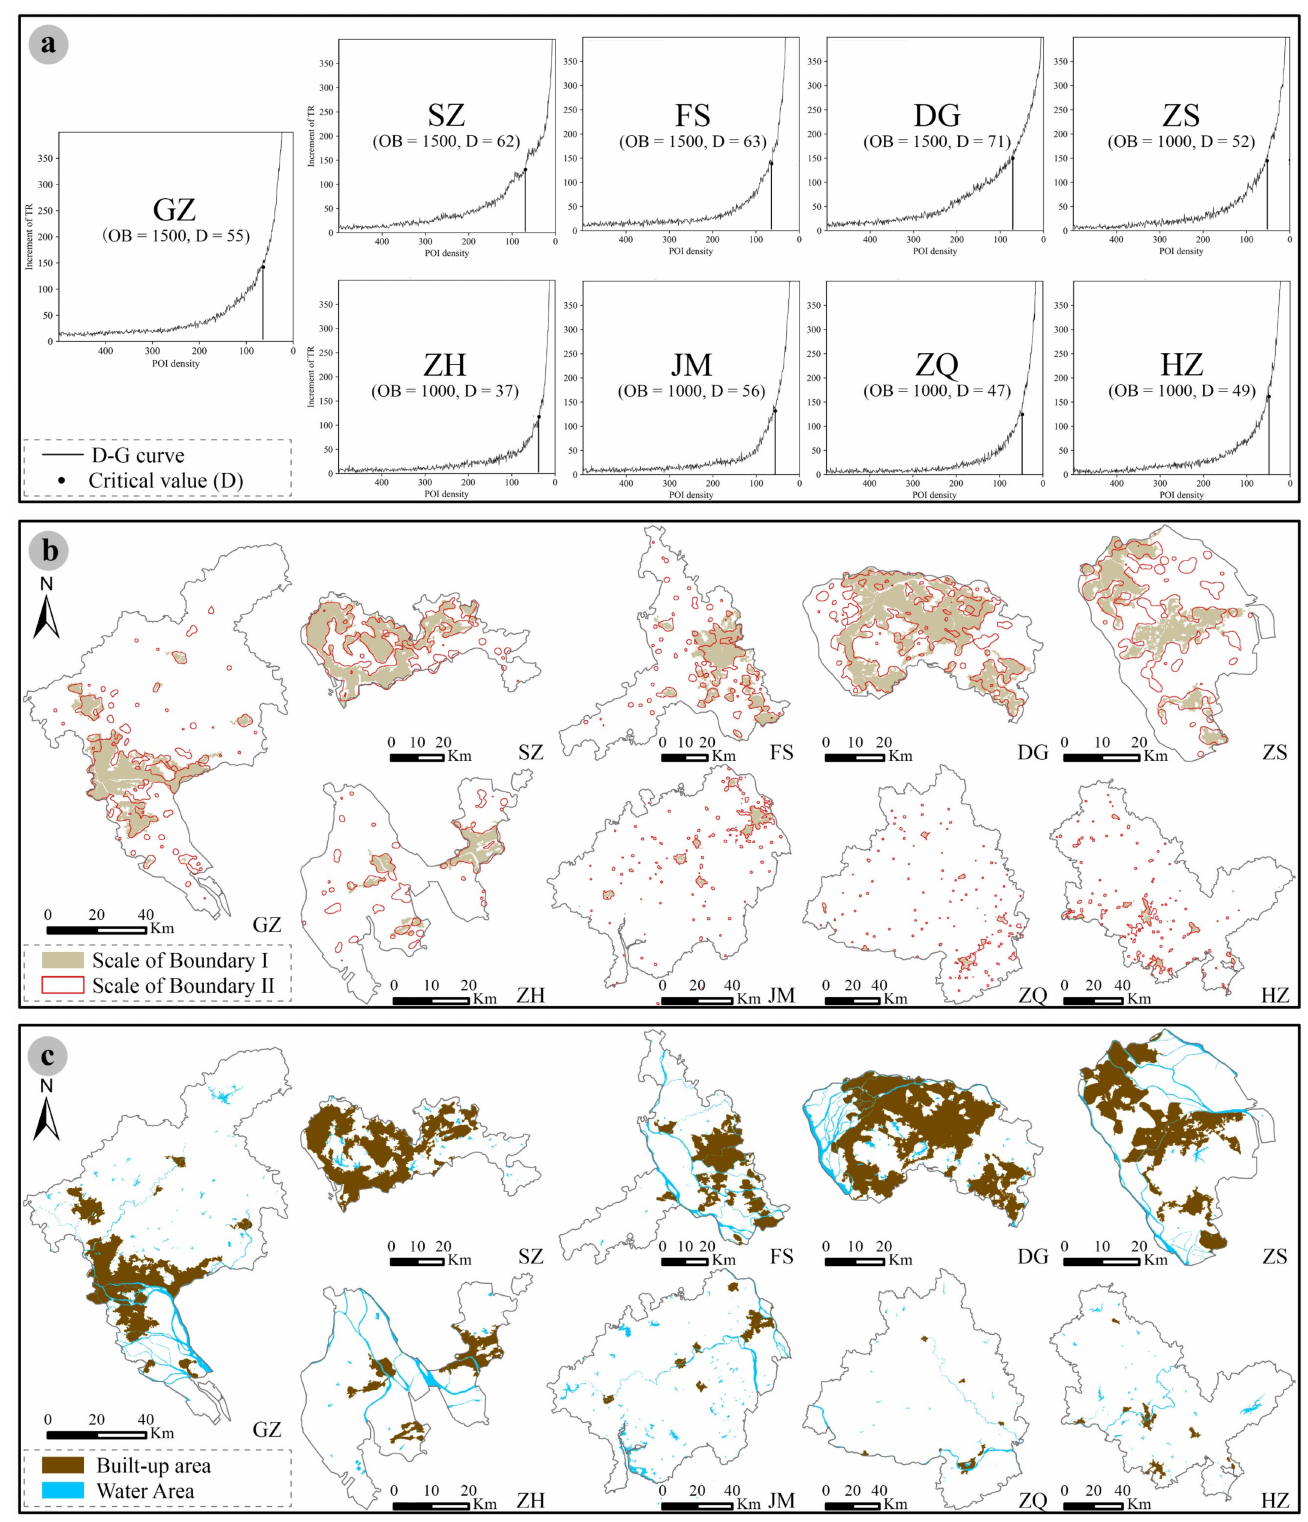
Figure 6. Built-up area extraction of the nine cities. ( a ) D-G graph; ( b ). Comparison between boundary I and boundary II; ( c ) The final extraction of the built-up